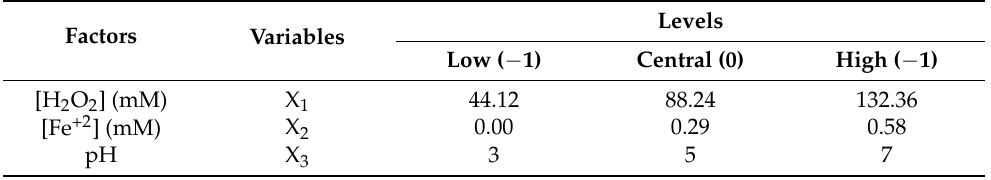
Table 1. Ranges and levels of independent variables for CCD on FP.